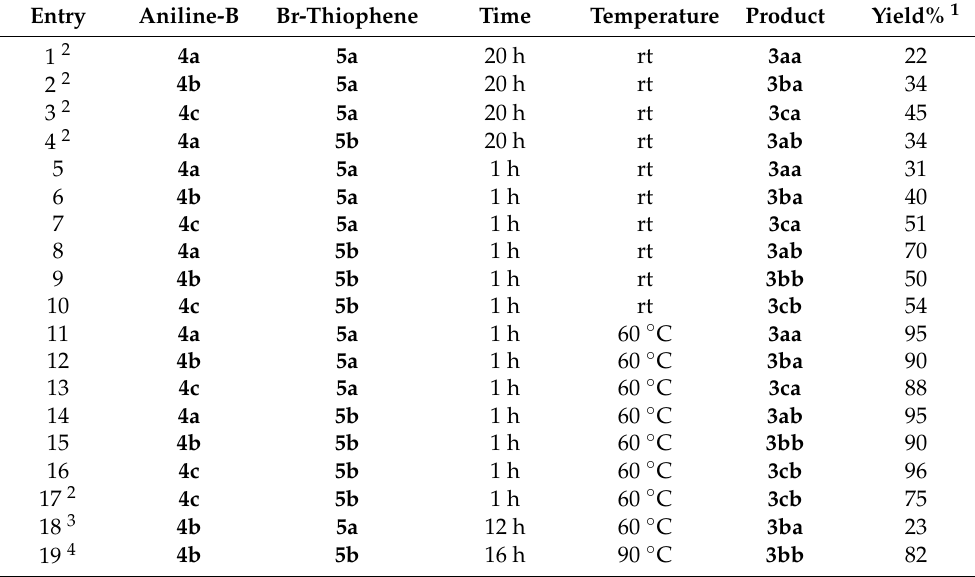
Table 2. Output of micellar Suzuki Cross-Coupling between aniline boronic acids and esters and bromo-thiophenes. Entry